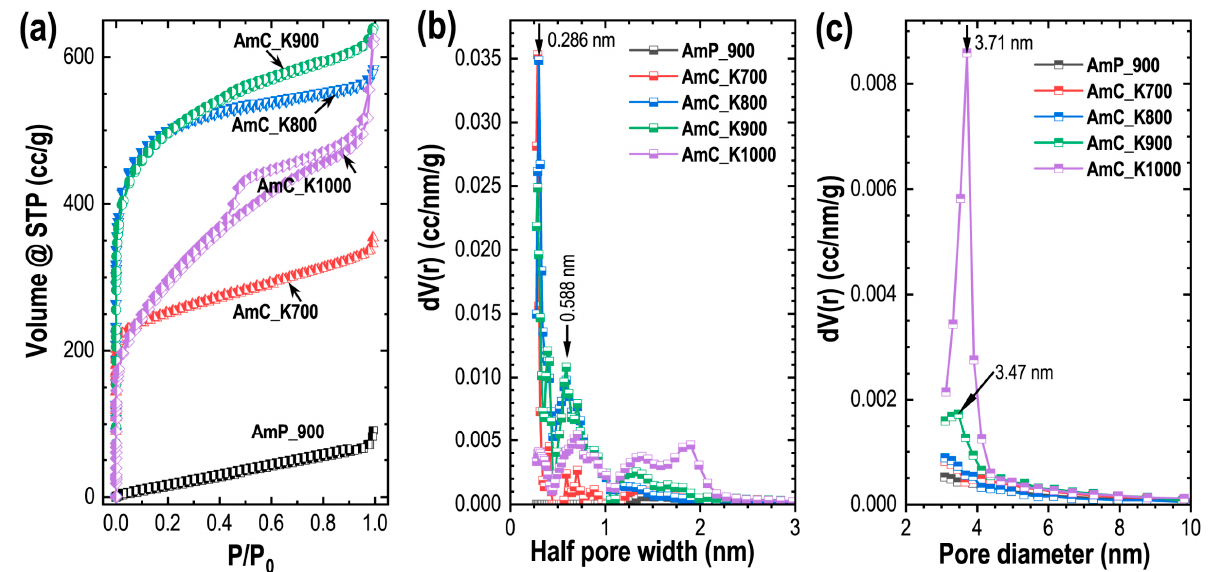
Figure 2. ( a ) Nitrogen sorption isotherms of AmP_900, AmC_K700, AmC_K800, AmC_K900 and AmC _K1000 samples; ( b ) pore-size-distribution curves obtained by the DFT analysis; and ( c ) pore- size-distribution curves obtained by the BJH analysis.